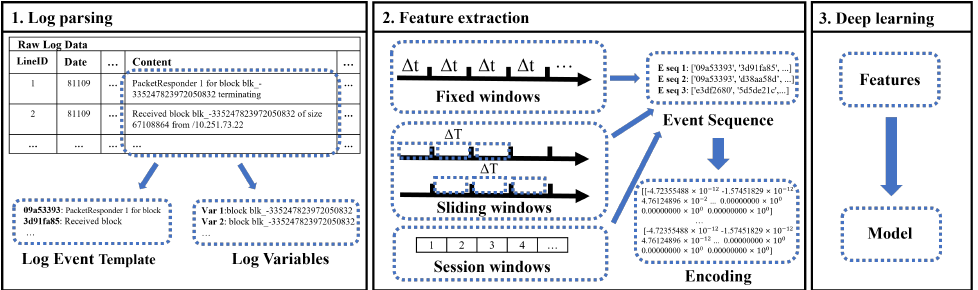
Figure 1. Deep learning-based log anomaly detection